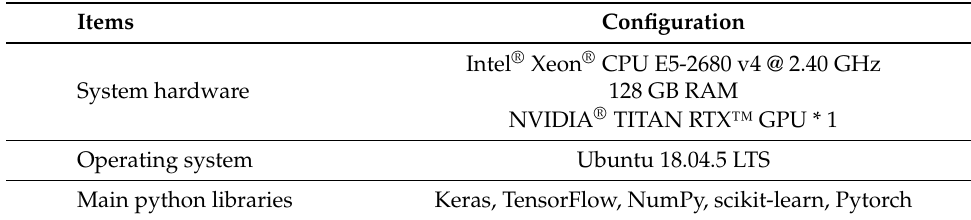
Table 3. Experiment